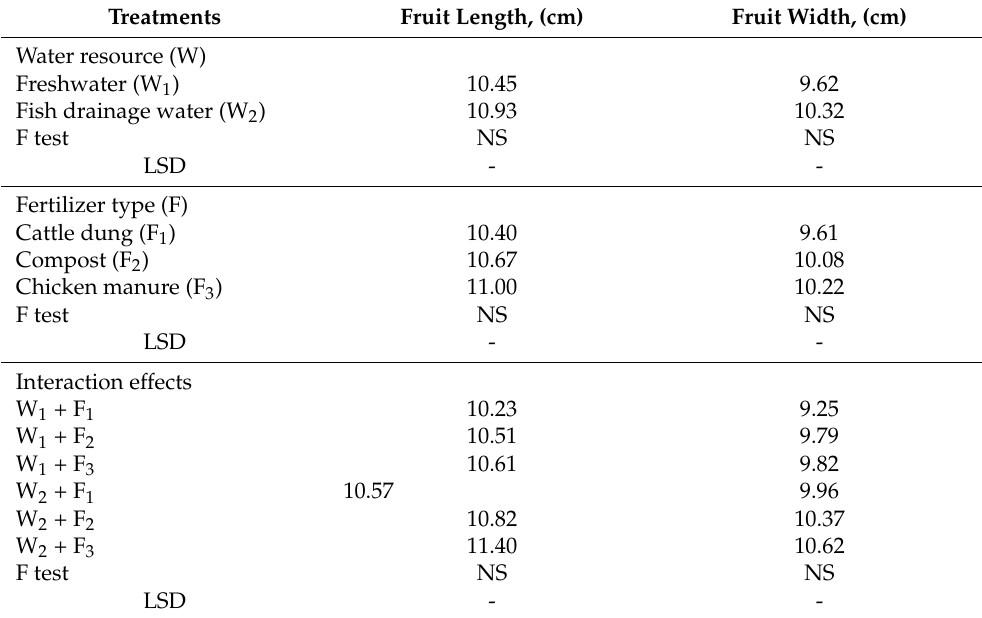
Table 5. Physical properties of pomegranate Fruits under different water resources and fertilizer